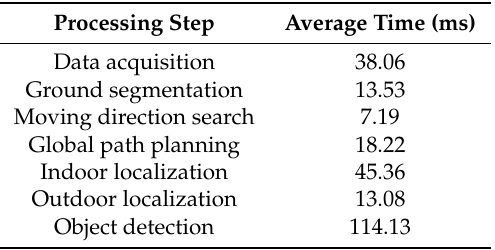
Table 5. Computational cost of the main